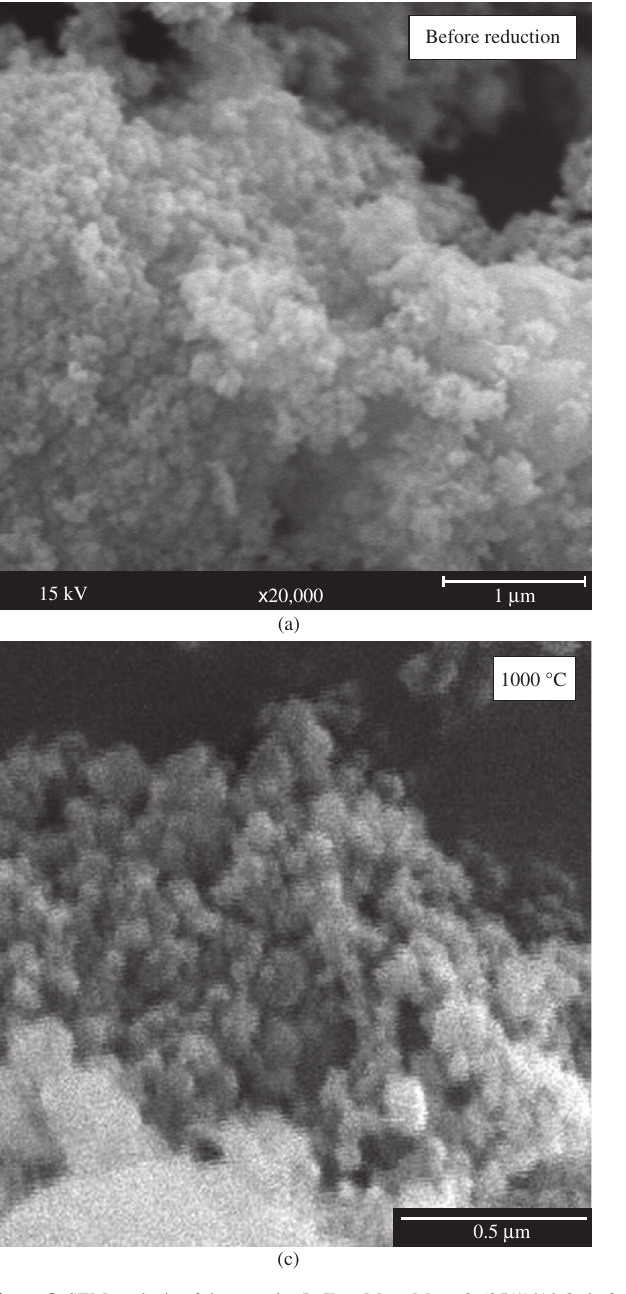
Mn Mo O (25%)/Al O before reduction and after reduction at 900, 1000 and 1100 °C. 0.90 0.08 0.02 3 2 3